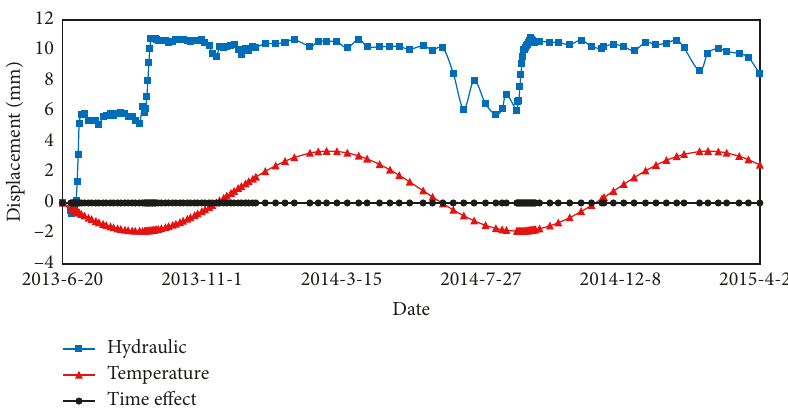
Figure 6: Displacement component result of the monitoring point PL1-1. Table 2: Initial modulus and ranges of different